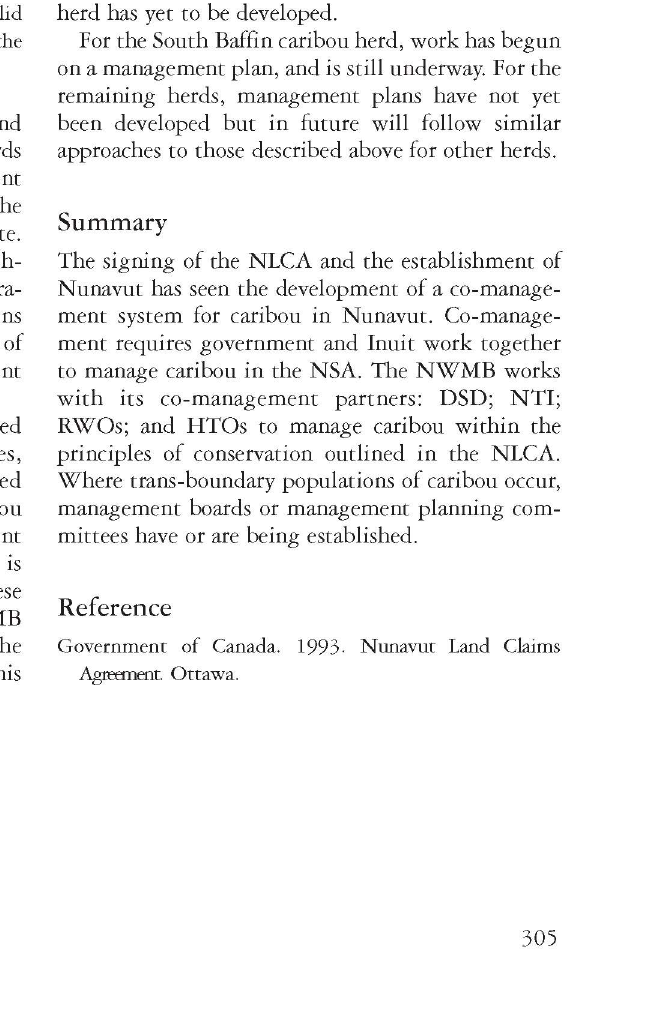
Fig. 2. Relationship between co-management partners responsible for caribou management in Nunavut. Dashed lines indicate advisory relationship, solid line indicates decision authority. Arrows show the direction of